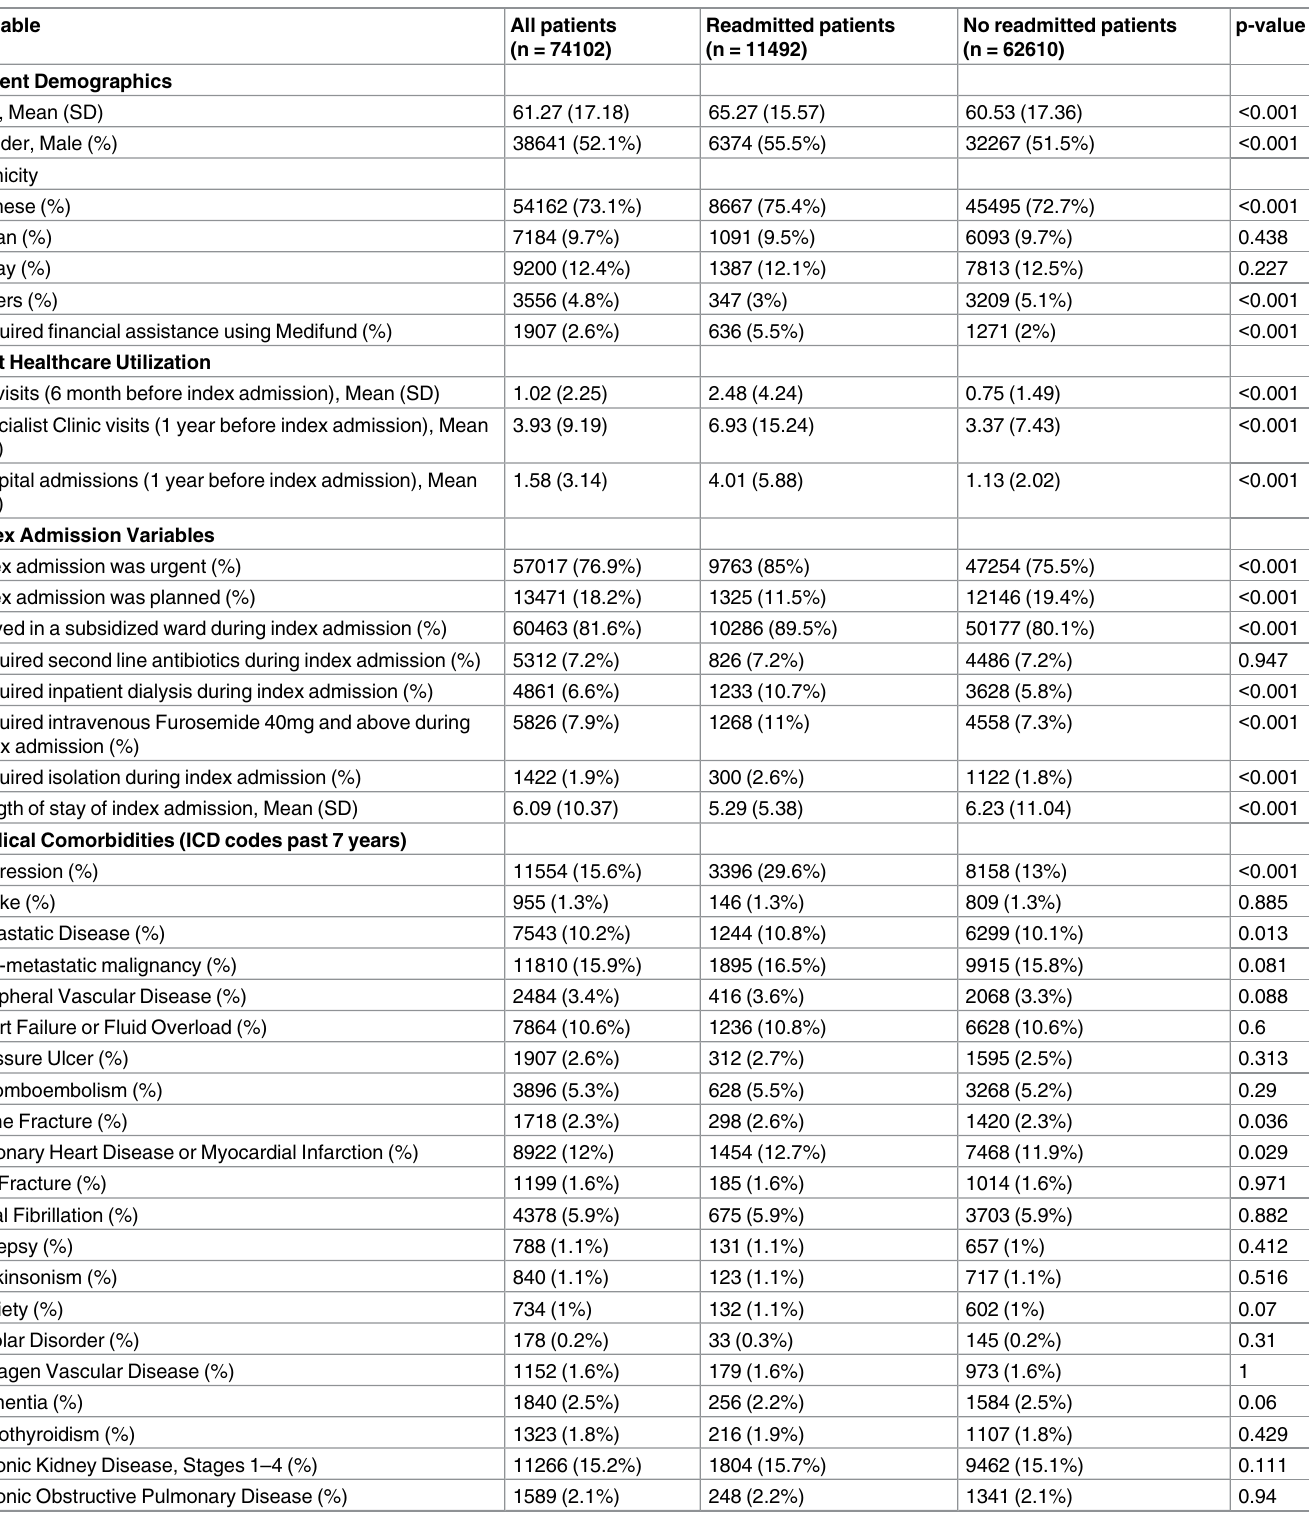
Table 1. Baseline characteristics by 30-day hospital readmission